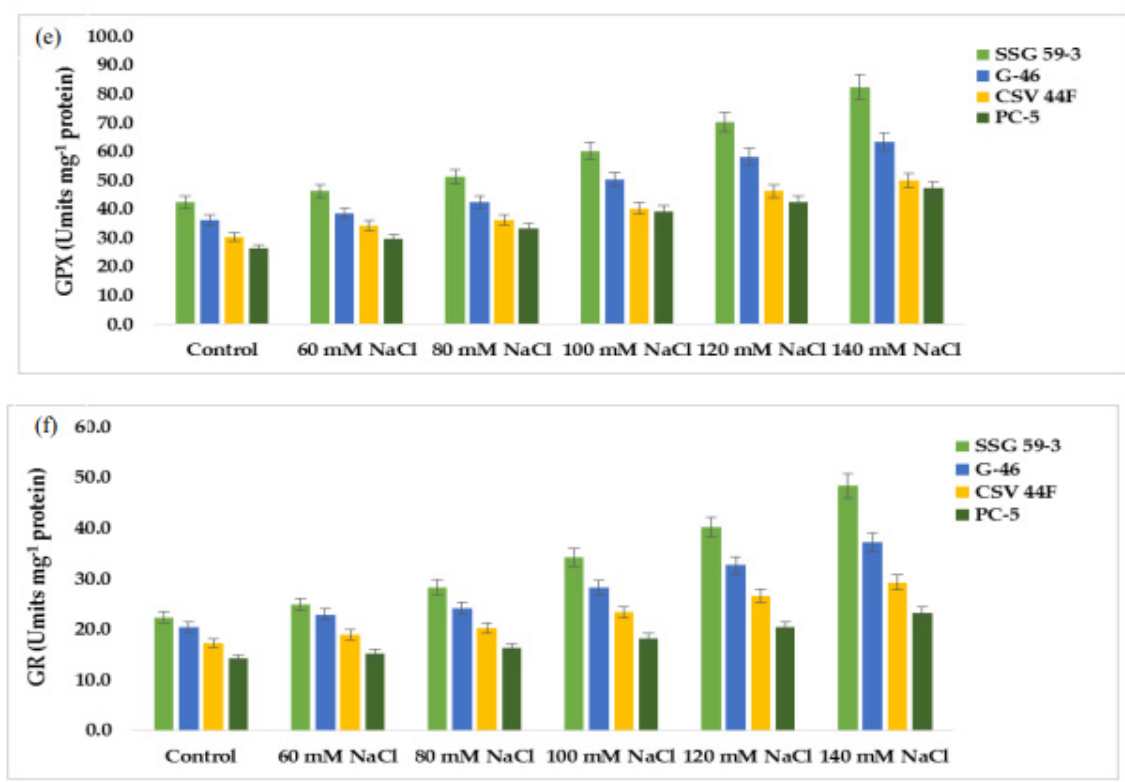
Figure 7. Effect of salt stress on ( a ) superoxide dismutase (SOD), ( b ) catalase (CAT), ( c ) peroxidase (POD), ( d ) ascorbate peroxidase (APX), ( e ) glutathione peroxidase (GPX), and ( f ) glutathione reductase (GR) of sorghum genotypes. Values are means of at least three replicates and significant differences between means, as determined by Tukey’s test ( p < 0.05).